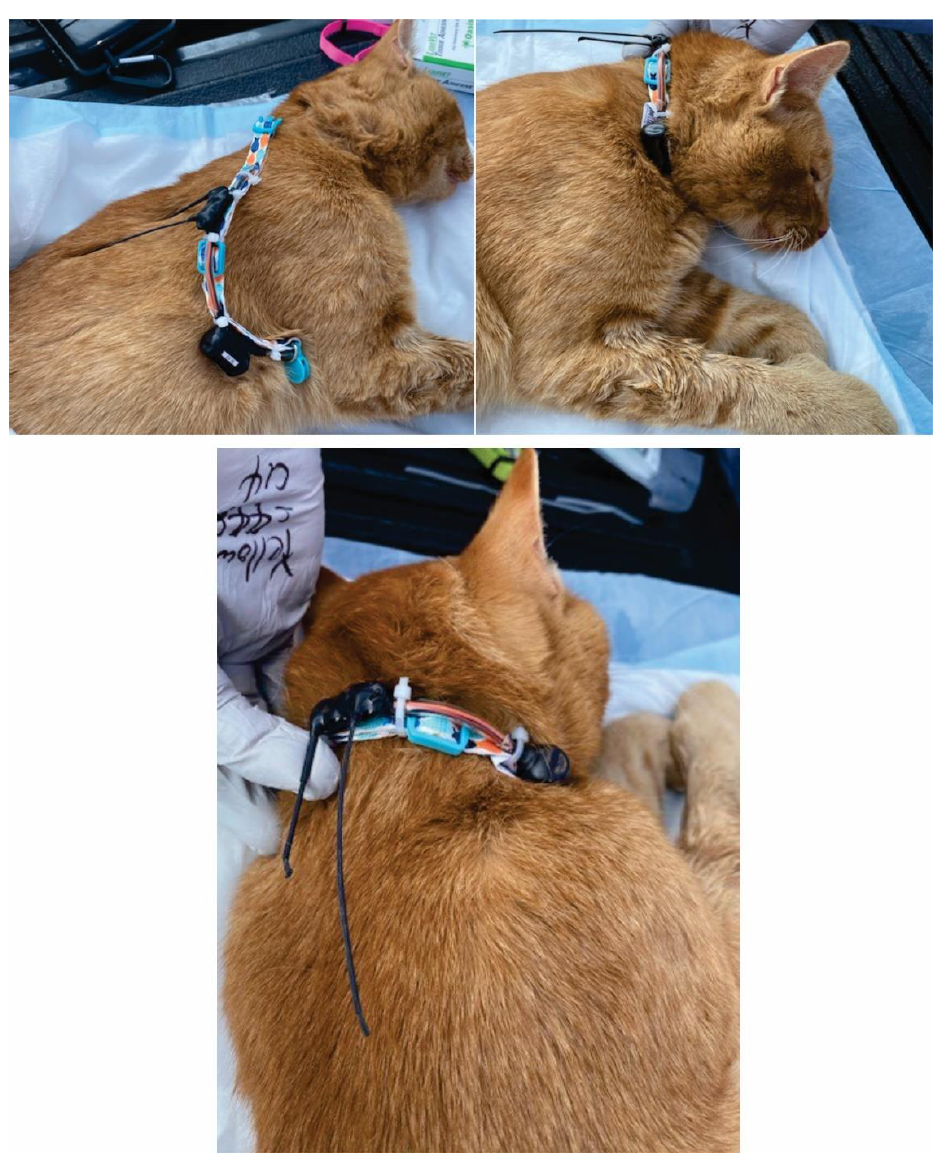
Figure 1. GPS collar placement on a free-roaming cat trapped on a mink farm in Utah in October 2020.